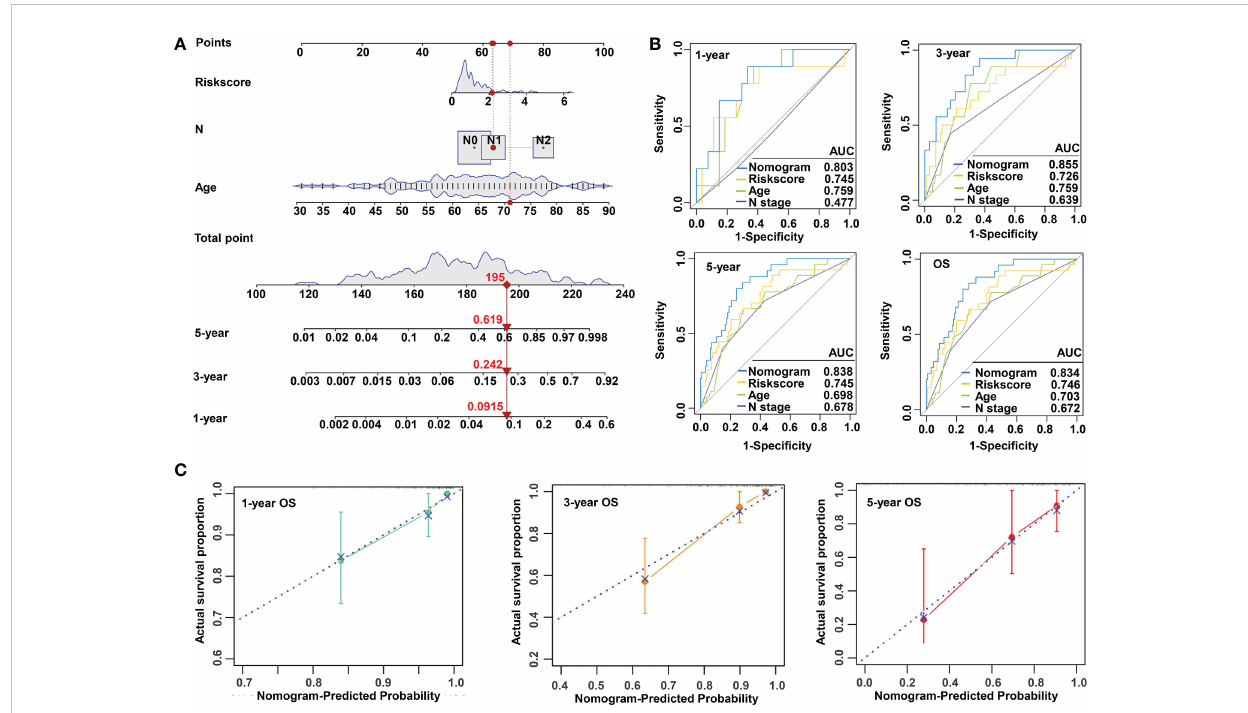
FIGURE 4 Construction and validation of a risk model based on m 5 C methylation regulators. (A) The predictive nomogram integrating the risk score and clinicopathological parameters for 1-, 3-, and 5-year OS in READ patients from the TCGA cohorts. (B) The ROC for nomogram and independent clinical parameters for 1-, 3-, and 5-year OS based on the TCGA cohort in READ patients. (C) The calibration curve depicted for 1-, 3-, and 5-year nomogram in TCGA. OS, overall